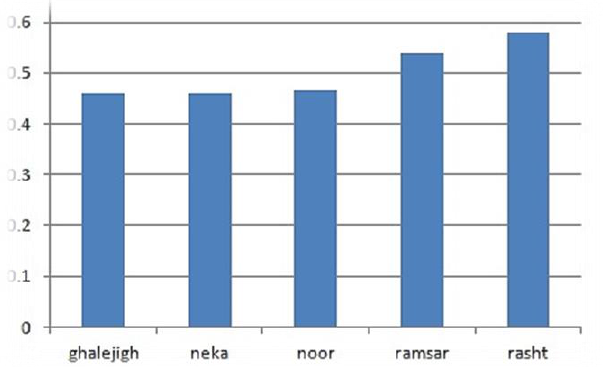
Figure 7. Ranking risk facility of 9 region in gas